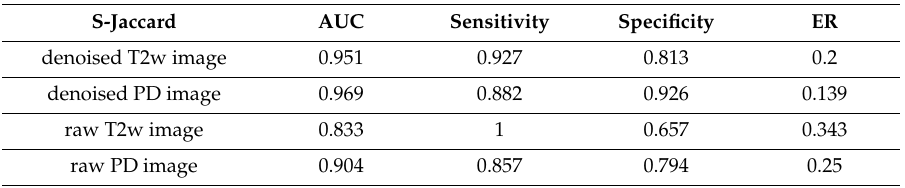
Figure 7. ROC curves for S-Jaccard computed for glioma images in D1 dataset (top) and D2 dataset (bottom), ( a ) raw T2w image, ( b ) raw PD image, ( c ) denoised T2w image, and ( d ) denoised PD image. Table 2. The cut-points ER, area under the curve AUC and related sensitivity and specificity values, for S-Jaccard computed for glioma